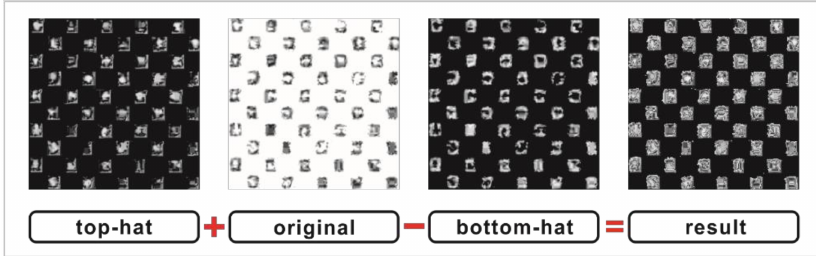
Figure 8. Gray-level morphological operation processing.